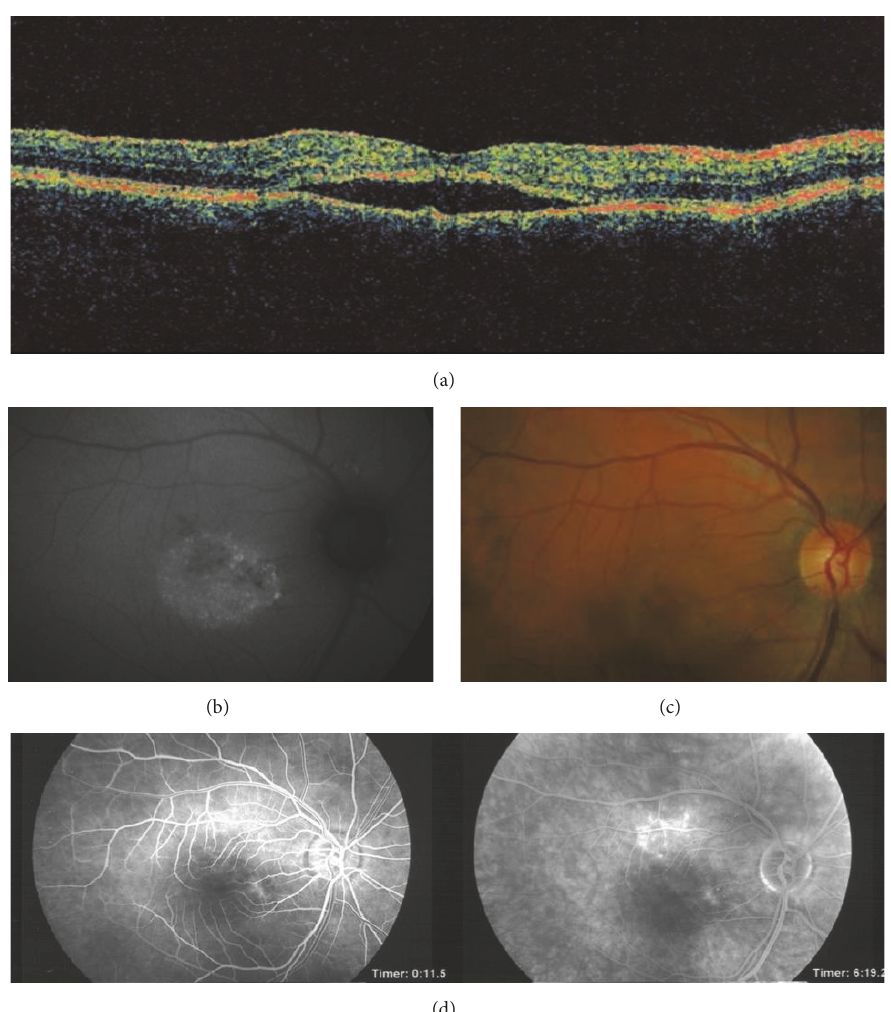
Figure 2: Optical coherence tomography (a) is showing pigment epithelial detachment of the neurosensory retina. Fundus photography (b, c) and fluorescein angiography (d) in the right eye of a 38-year-old male patient. The patient had suffered, to variable degrees, from painless blurred vision, dyschromatopsia, and micropsia for more than 2 years. Fundus abnormalities included an irregular pattern of hypopigmentation of the retinal pigment epithelium, amorphous subretinal deposits, and a shallow serous detachment involving large parts of the posterior pole. These findings are highly suggestive of chronic central serous